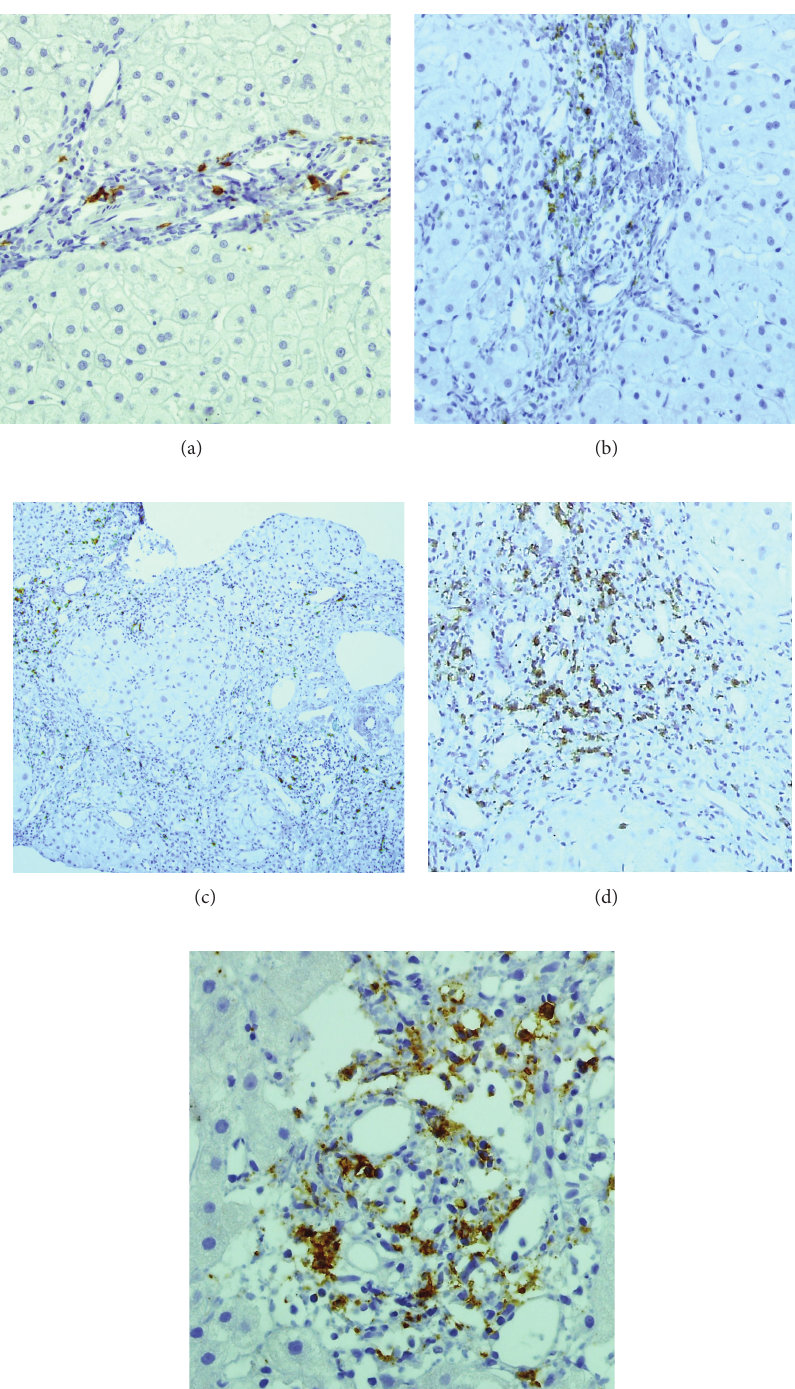
Figure 1: Representative microphotographs of CD20 marker by immunohistochemistry in hepatitis B virus-associated chronic liver diseases. ((a), (b)) Expression of CD20 in chronic hepatitis B patients without fibrosis and low fibrosis (original magnification, 200). ((c), (d), (e)) CD20 immunoreactivity was observed throughout the portal region of high fibrosis chronic hepatitis B patients (original magnification, 100, 200, and